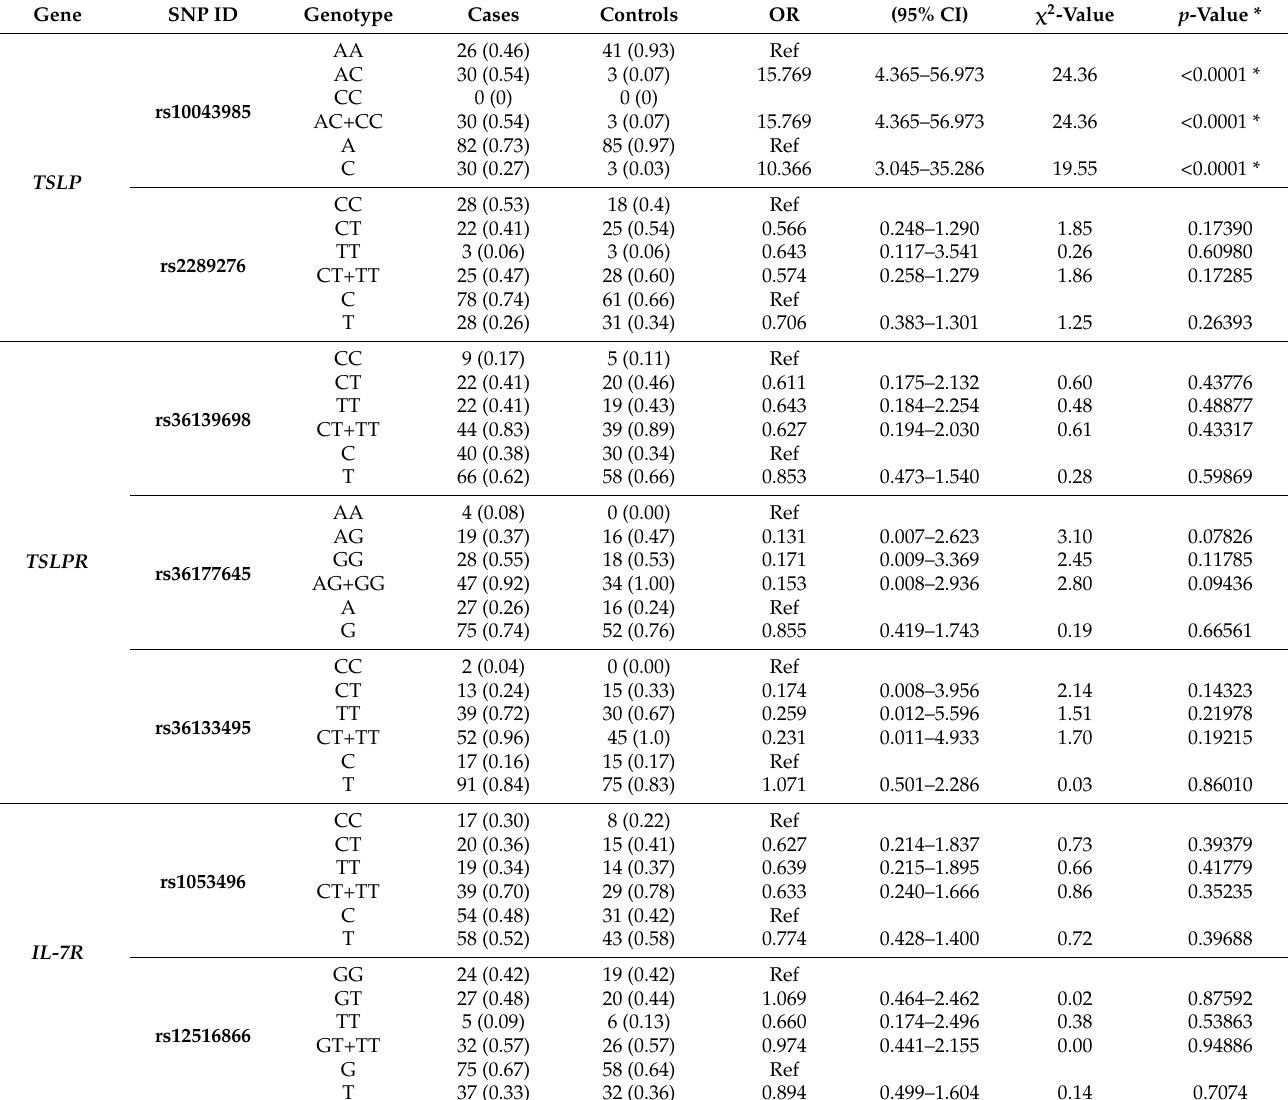
Table 6. Genotype frequencies of TSLP, TSLPR, and IL-7R gene polymorphisms CRC and controls in individuals above 57 years of